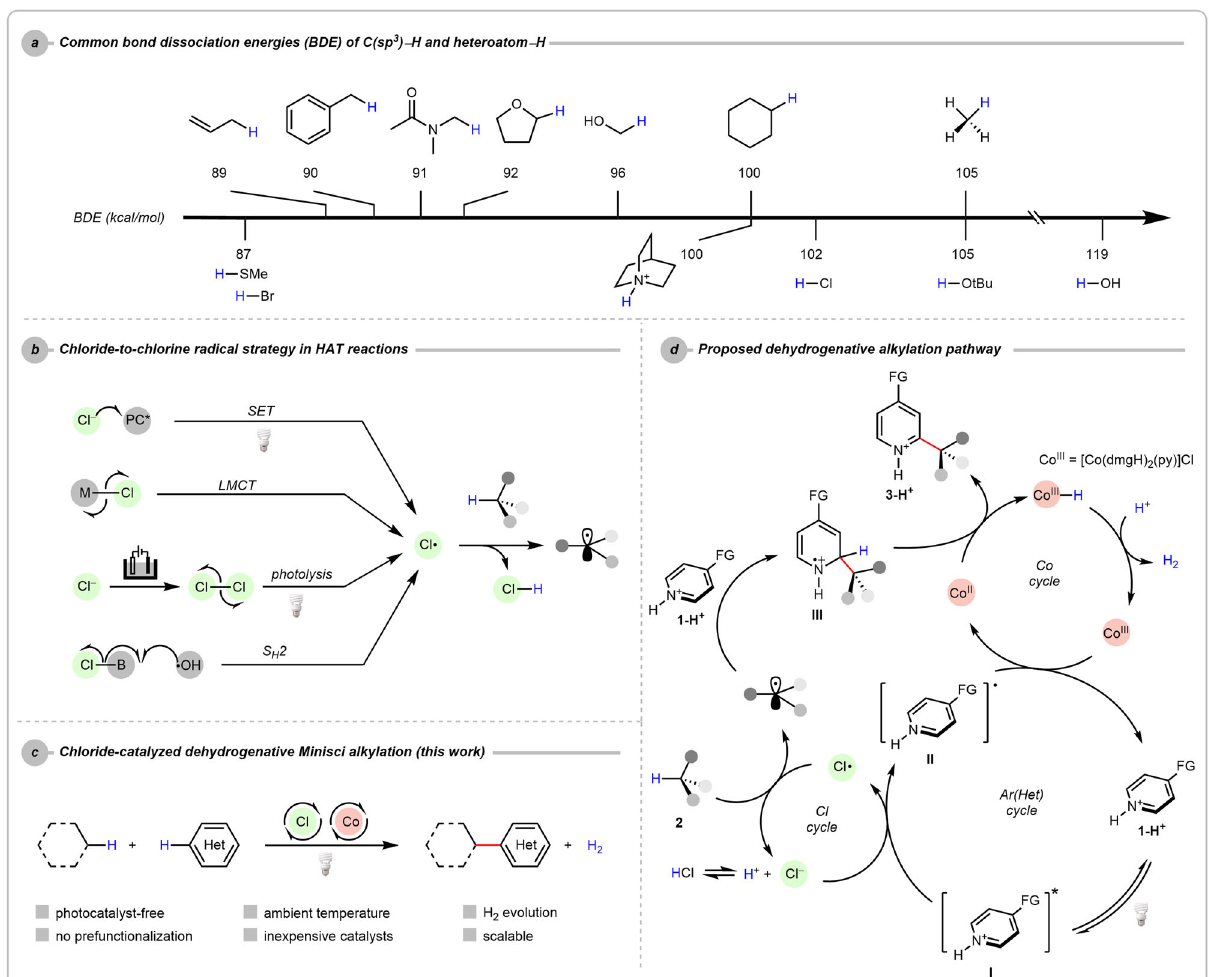
Fig. 1 From inspiration to reaction design. a Bond dissociation energies (BDEs) of aliphatic C – H bonds and some protonated heteroatom species. b The representative chlorine radical generation method in HAT reactions. c The designed dehydrogenative Minisci alkylation enabled by catalytic chlorine radical generation. d The proposed dehydrogenative Minisci alkylation mechanism; SET single-electron transfer, LMCT ligand-to-metal charge transfer, S H 2 bimolecular homolytic substitution, FG functional